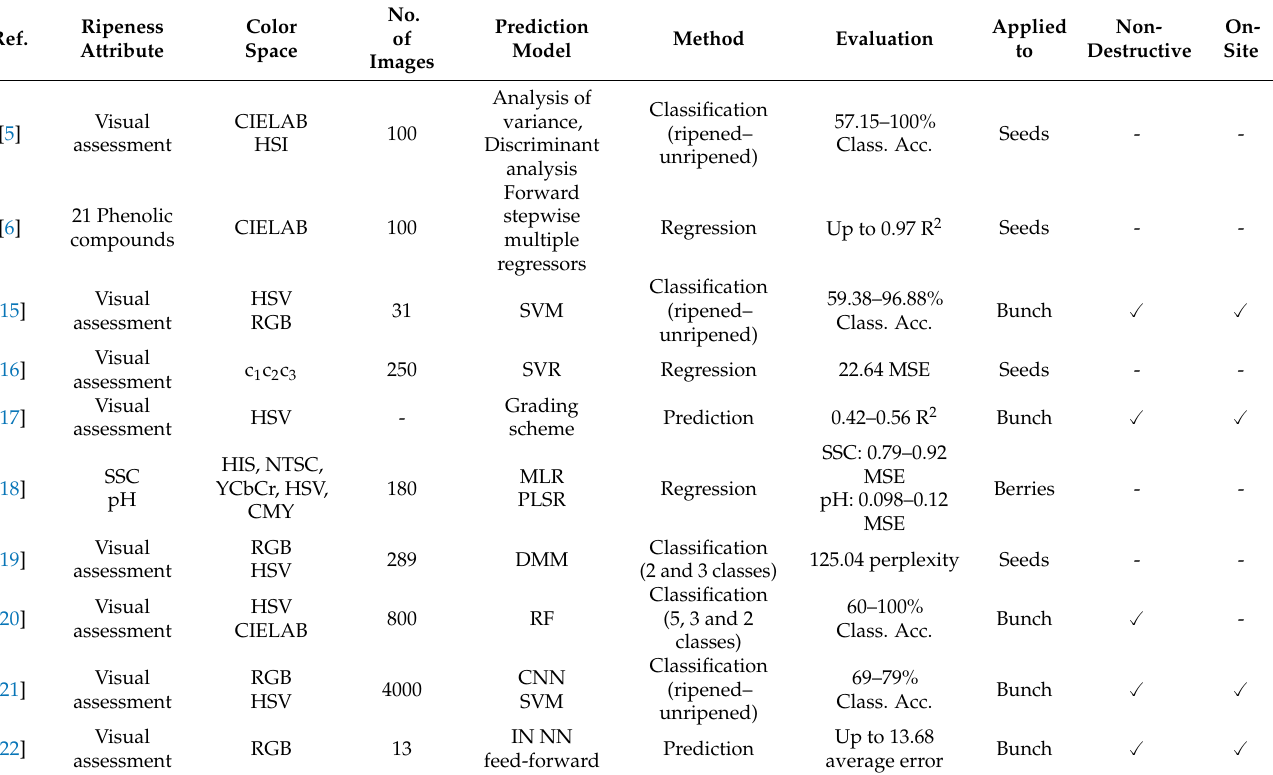
Table 1. Comparative table of grape ripeness estimation methods of the literature and the proposed method (PM), based on color